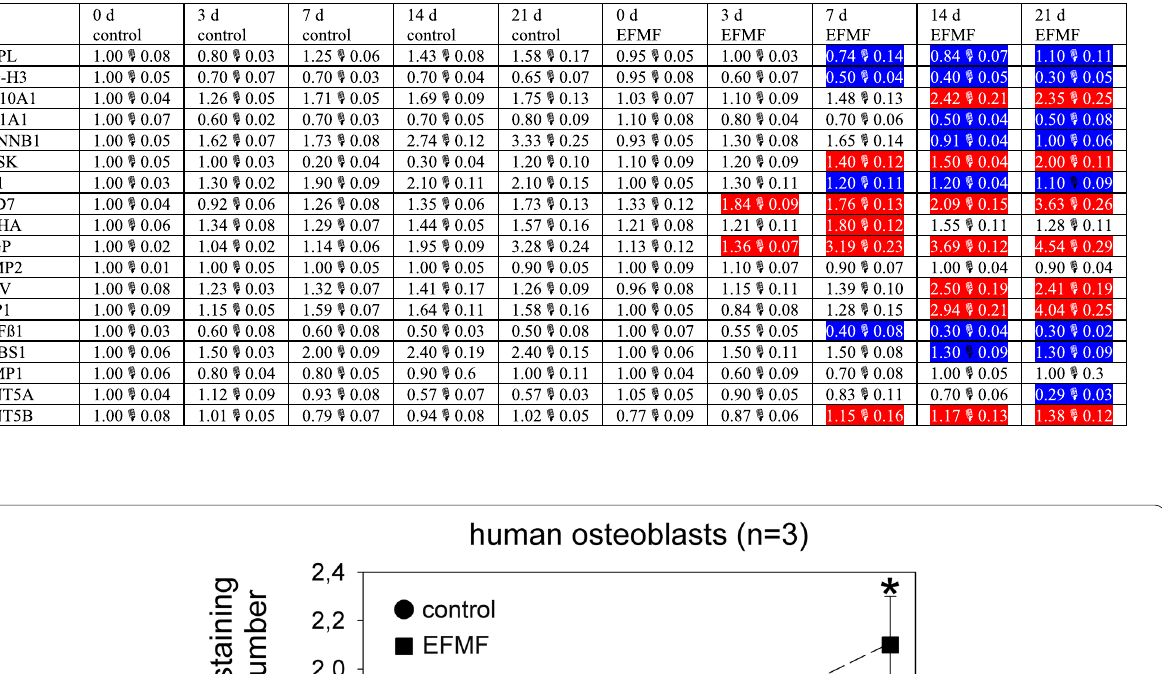
SEM). Significant increase ±